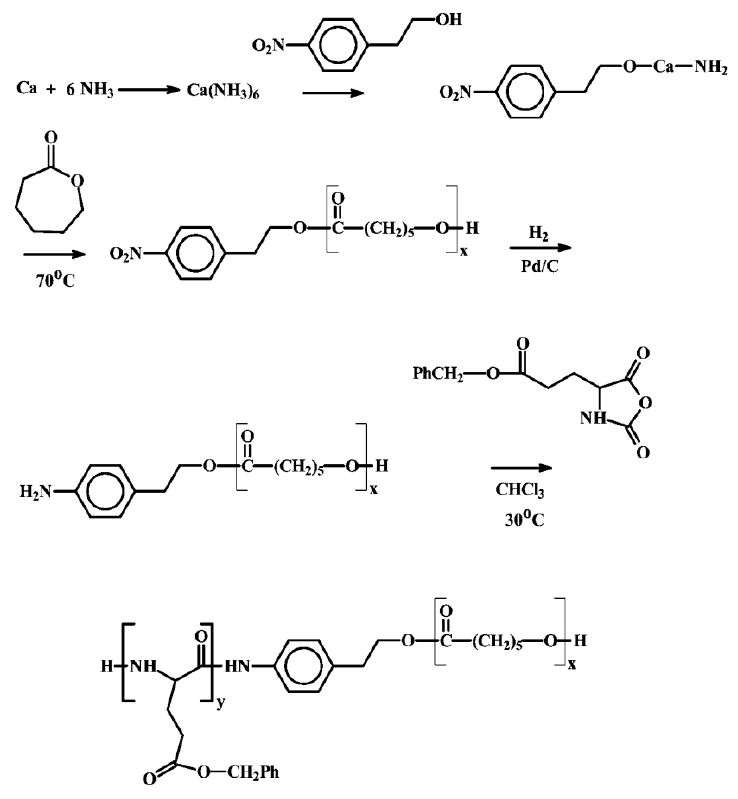
Figure 33. Strategy reported by Rong et al. [156] to prepare a biodegradable, poly( ε -caprolactone)- b -poly( γ -benzyl- L -glutamic acid) (PCL- b -PBLG) diblock copolymer.